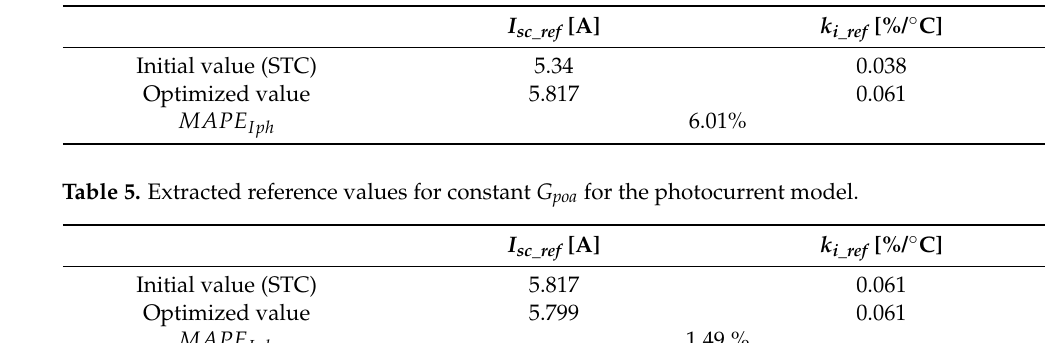
Table 4. Extracted reference values for constant T pv for the photocurrent model.